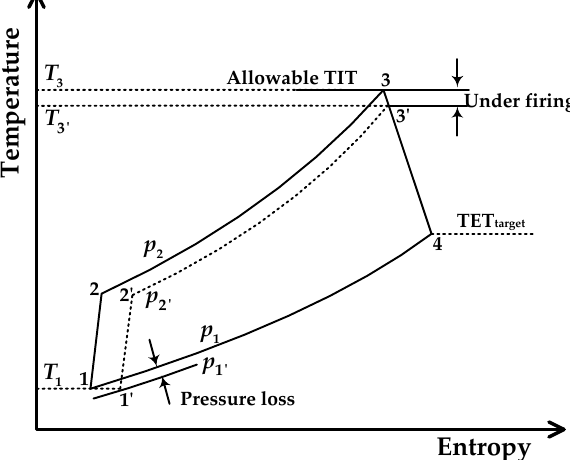
Figure 12. Changes in the cycle parameters on the temperature-entropy diagram due to the compressor inlet pressure loss.